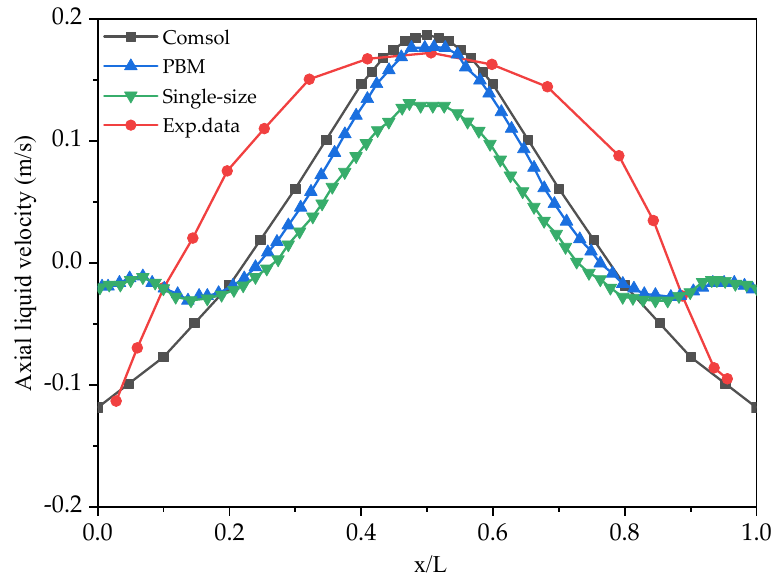
Figure 4. Comparison of the results of the different models and experimental data.